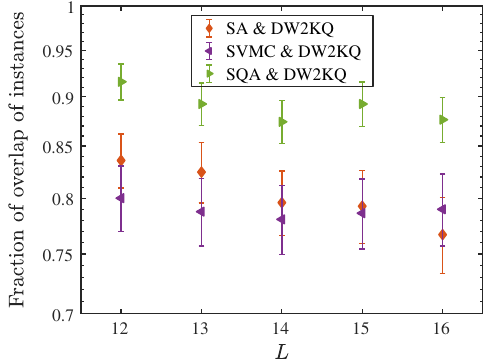
FIG. 8. Overlap of the instances that fall below the median TTS for the classical solvers and the DW2KQ. We calculate the TTS for 1000 instances with each solver ’ s respective optimal annealing time for the median at a given size L , and check which instances fall below the median TTS. Shown is the (normalized) fraction of the overlap of the instances between the solvers. Further details are given in Appendix I. Error bars represent 95% confidence intervals ( 2 σ ) calculated using 1000 bootstraps of 1000